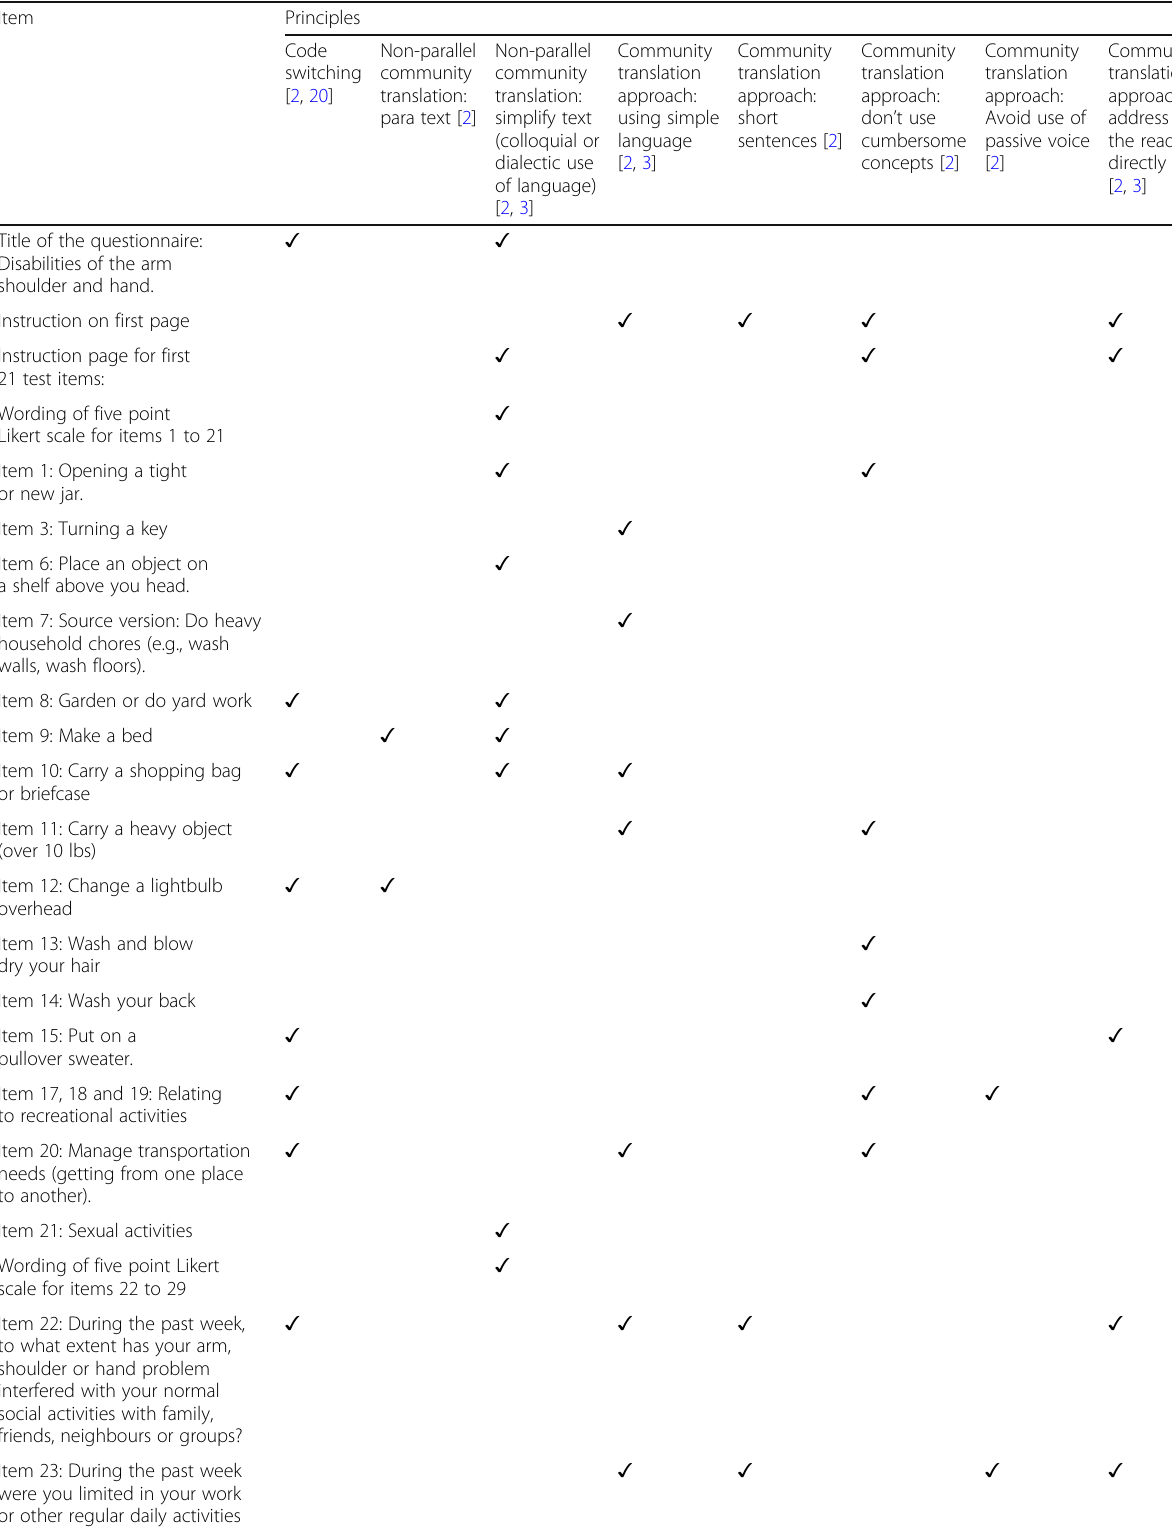
Table 2 Principles of community translations applied to test items